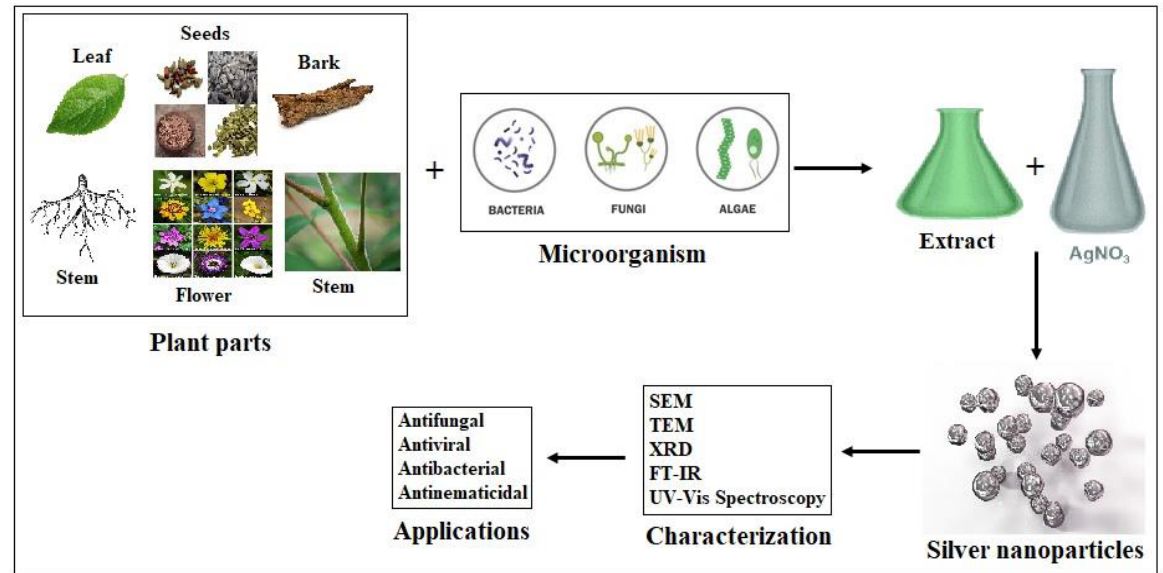
Figure 7. Schematic representation of the green synthesis of AgNPs from plant parts and microorganisms, their characterisation, and their activity [108].